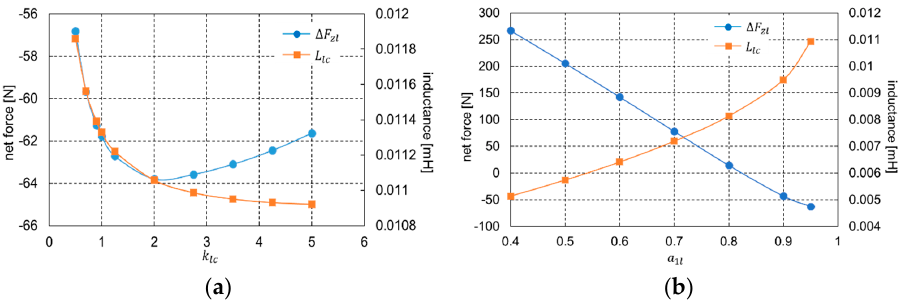
Figure 10. Net force and inductance of the AHMB lower side; ( a ) dependence on the coil aspect ratio k lc ; ( b ) dependence on the p.u. variable a 1 l .